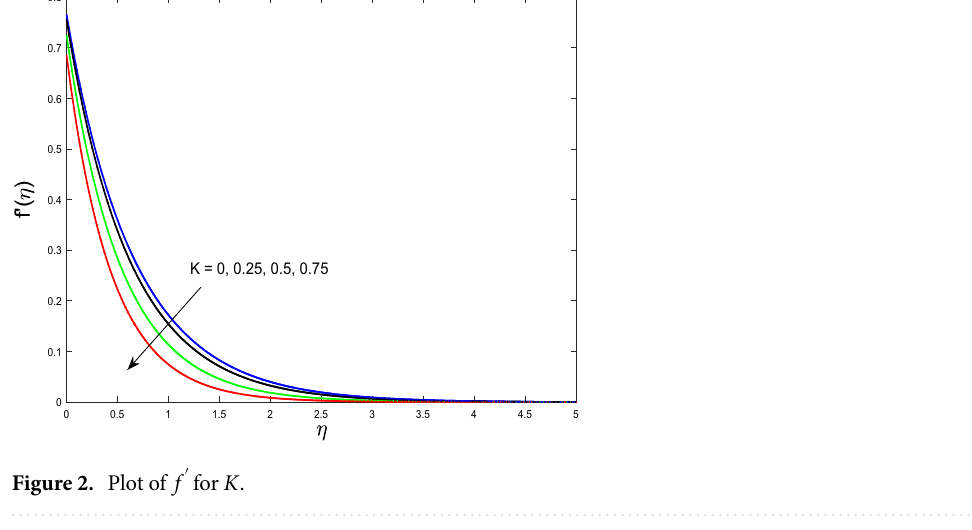
Figure 2. Plot of f ′ for K